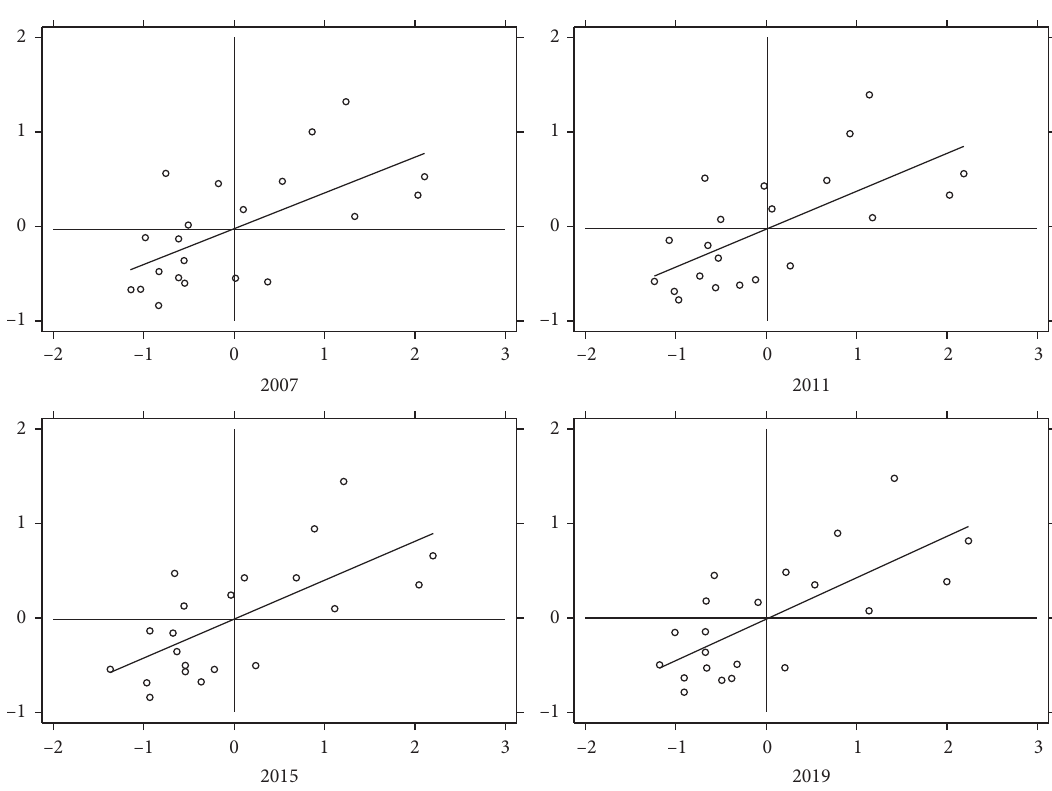
Figure 2: Local Moran’s scatter